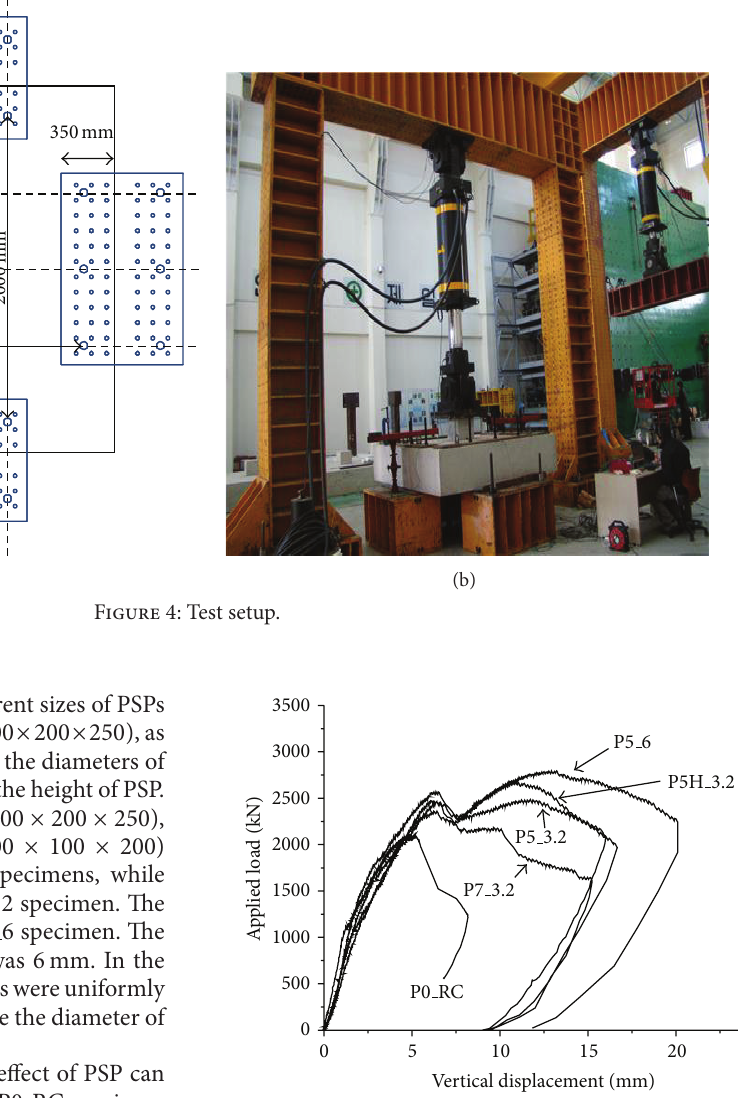
Figure 5: Applied load versus vertical displacement at the